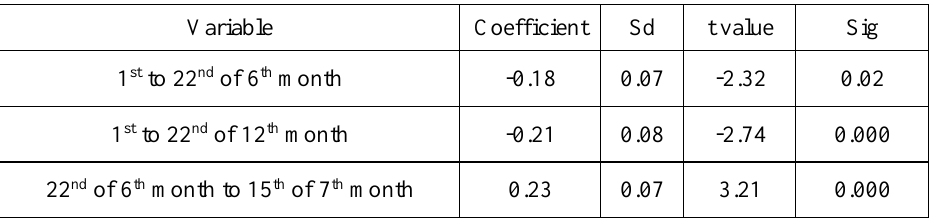
Table 4: estimation of coefficients (in